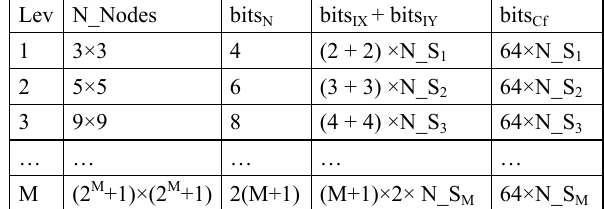
Table 4. Space requirements for the multi resolution